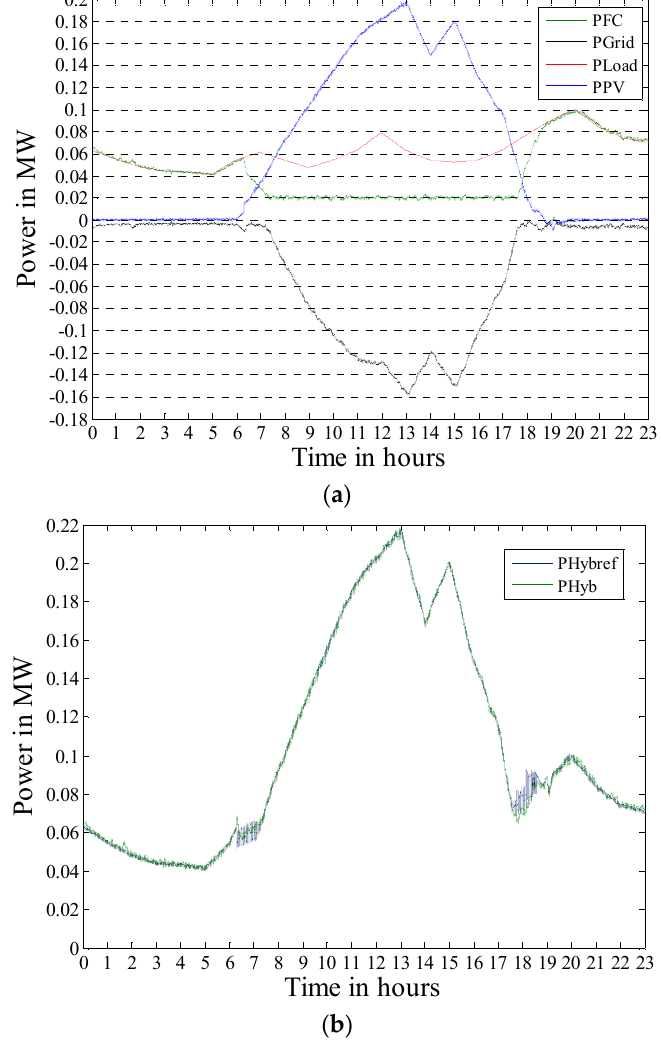
Figure 14. Simulation results of the power management system. ( a ) Overall system operating strategy; ( b ) Hybrid system reference and actual value.